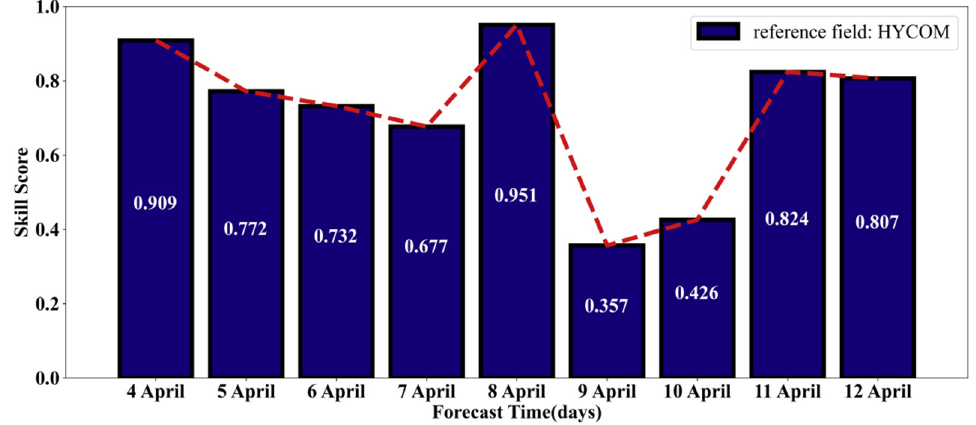
Figure 11. The ELD model forecasting skill score (in comparison to HYCOM